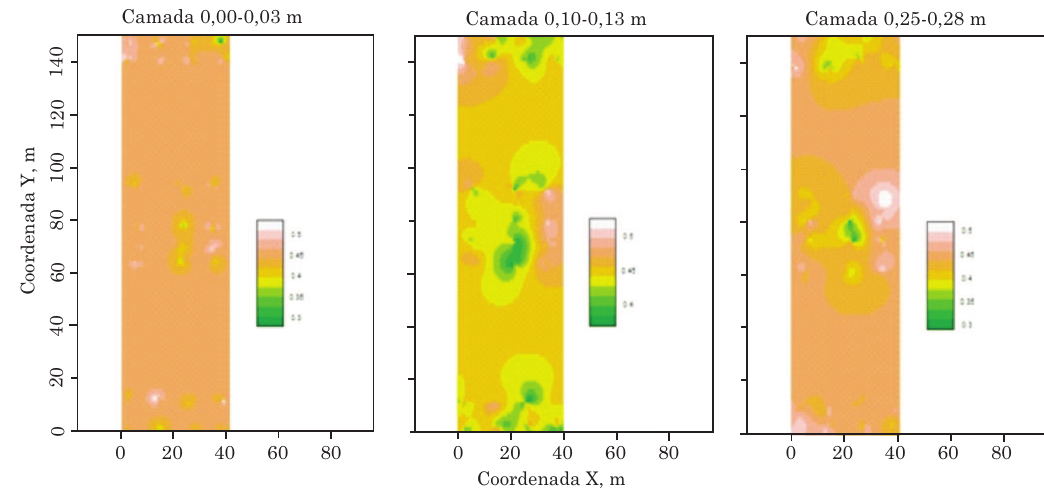
Figura 4. Mapa da distribuição espacial da microporosidade do solo na área de